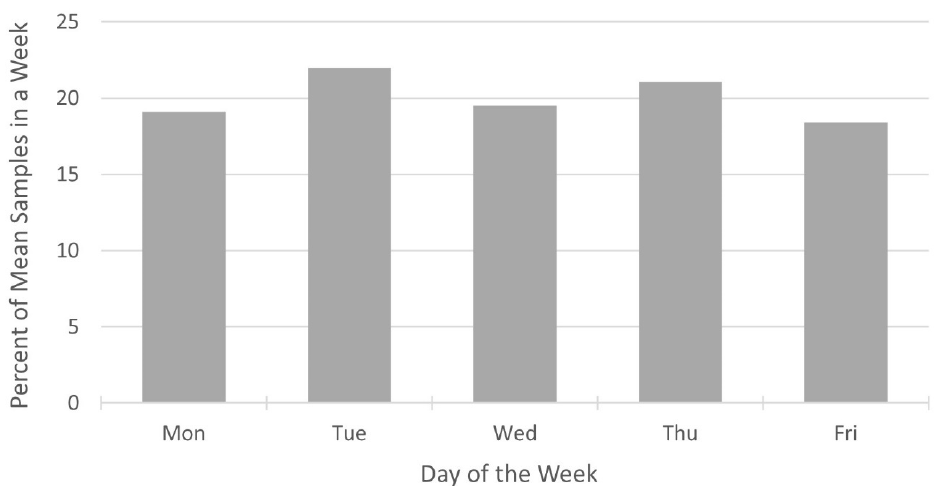
Figure 4. Distribution of mean samples per day generated on weekdays (Mon–Fri). Mean samples in a week (Mon–Fri) is 15,684.